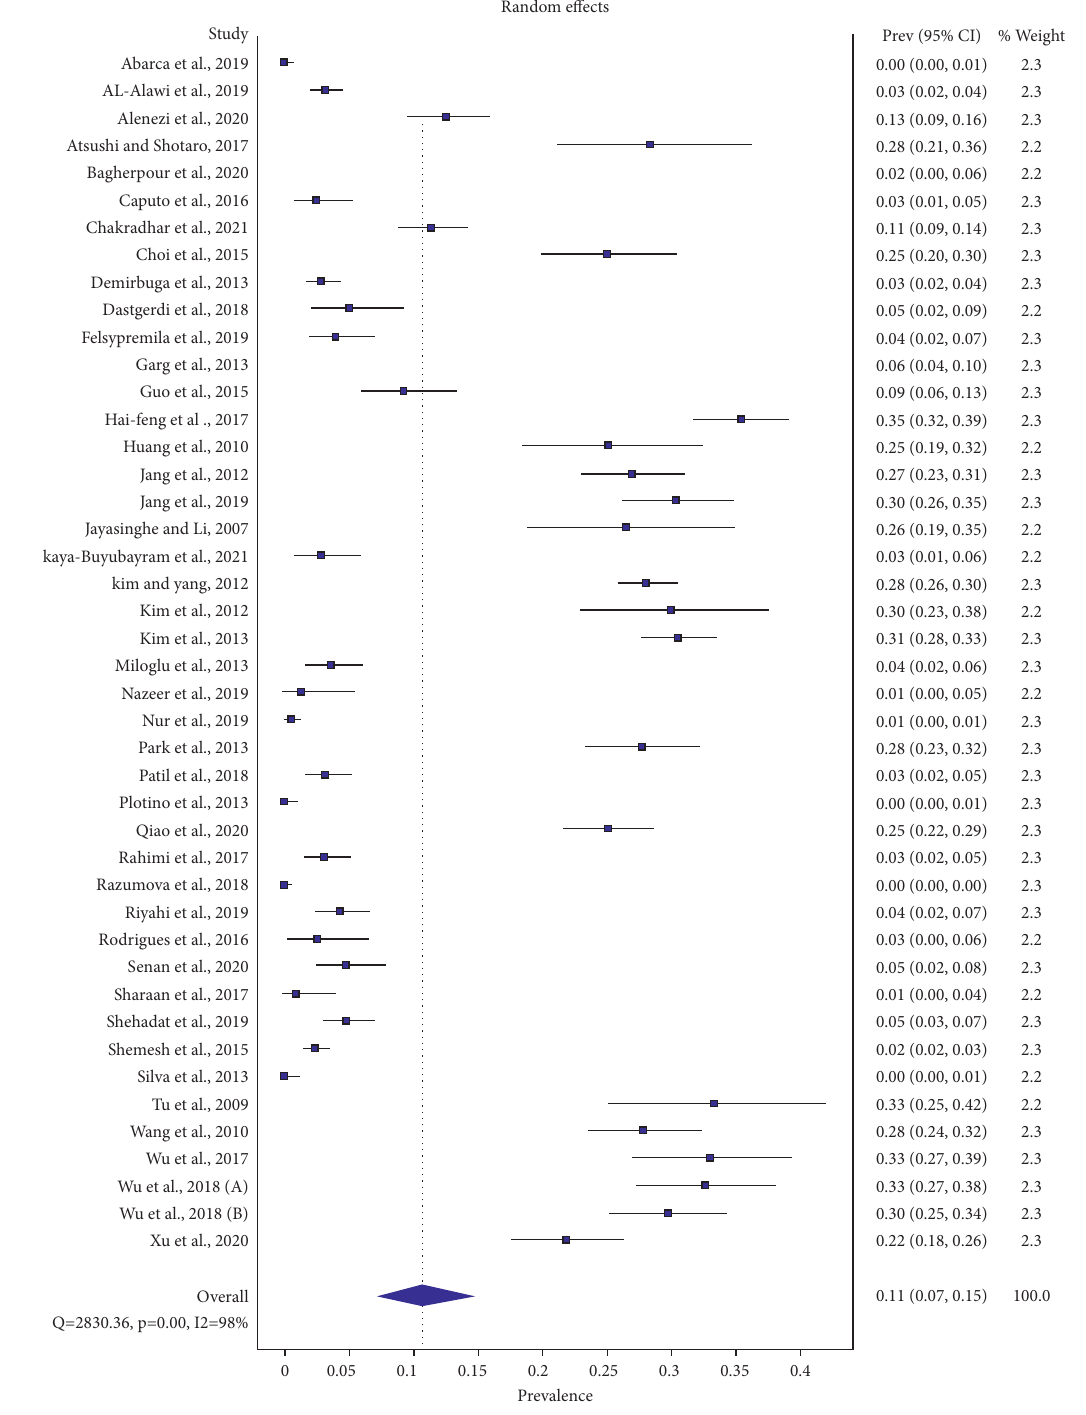
Figure 7: Global patient-level prevalence of three-rooted